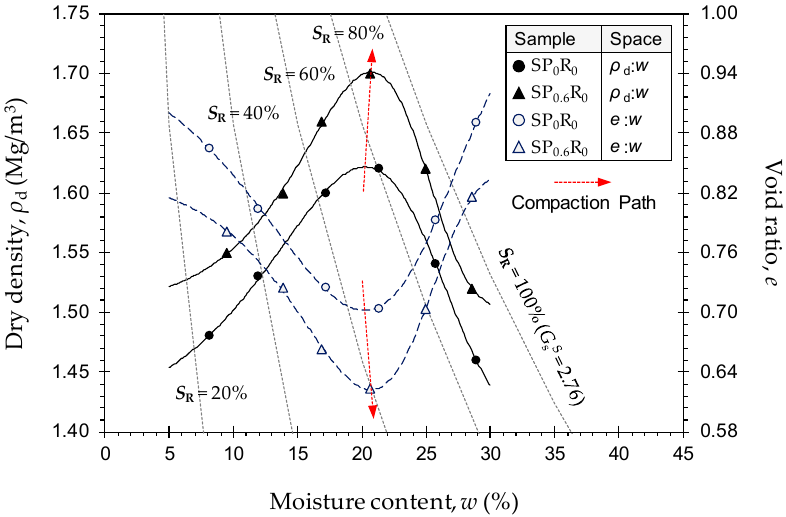
Figure 4. Standard Proctor compaction curves for the natural soil ( SP 0 R 0 ) and the sample treated with 0.6 g/l PAM ( SP 0.6 R 0 ).